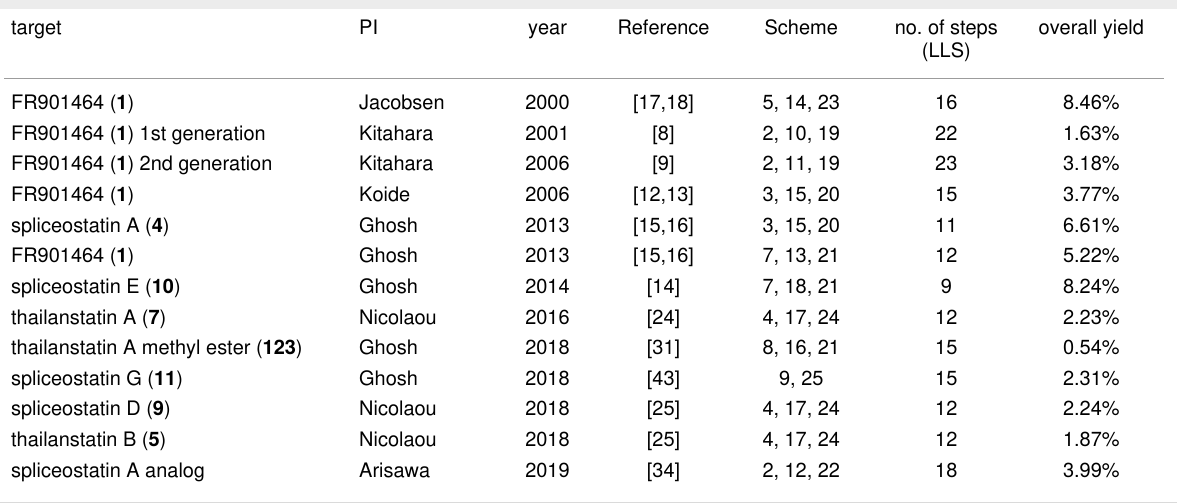
Table 2: Summary of the total